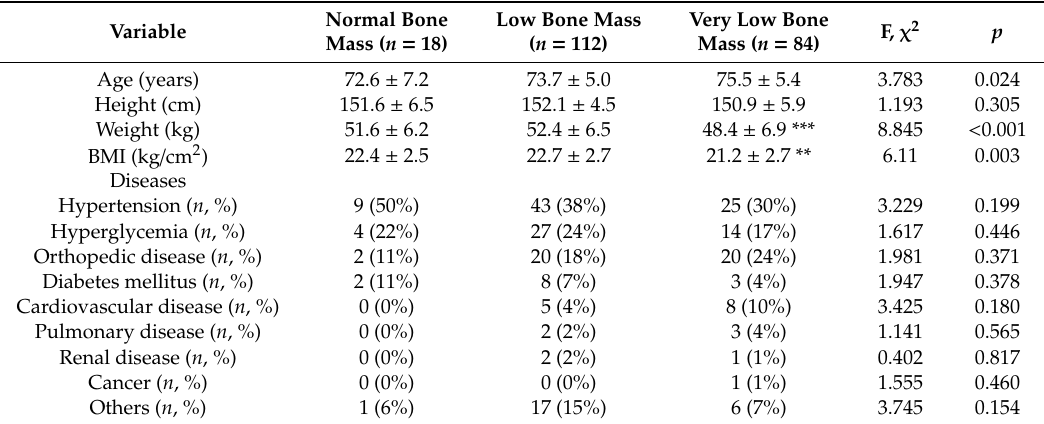
Table 1. Participants’ characteristics.